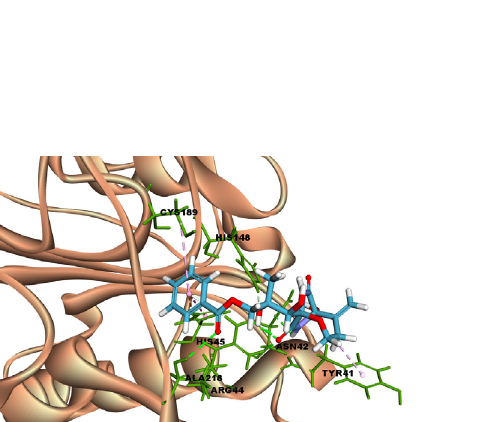
mycin benzoate at LGMN catalytic site.